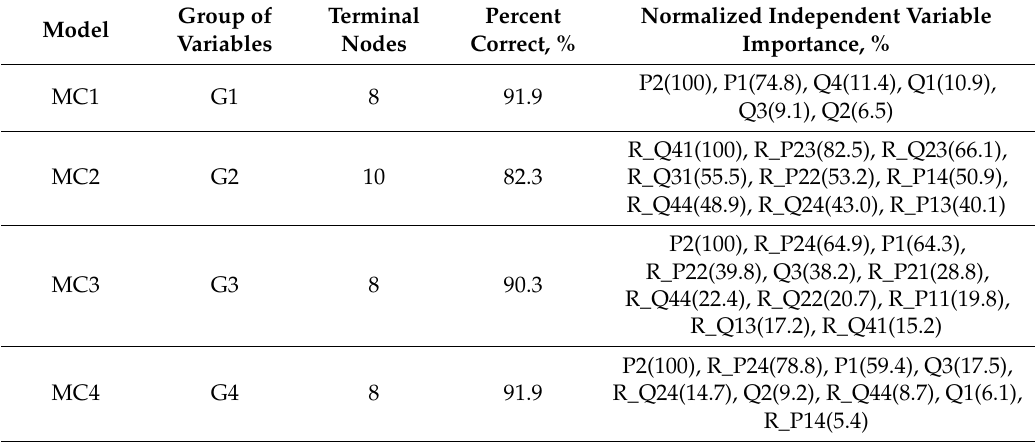
Table 6. Summary statistics of classification CART models for Competency 1 .